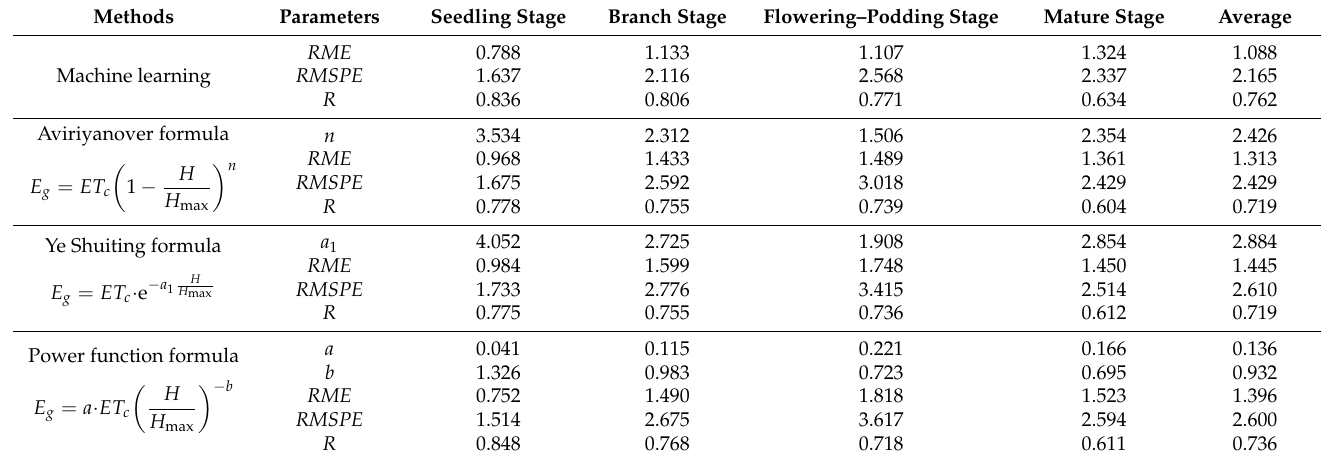
Table 3. Results and fitting errors of the machine learning and formula methods.